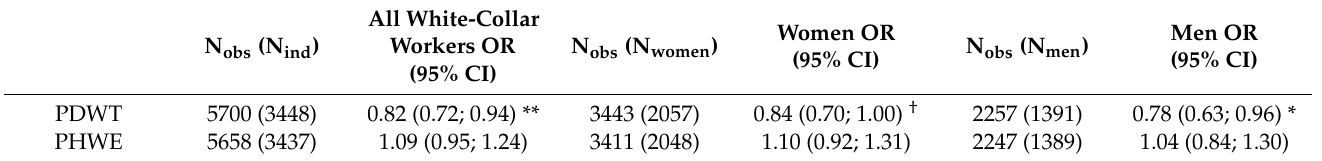
Table 2. White-collar workers. Odds ratio (OR) and 95% confidence interval (CI) of retired (1) vs. still in work (0) two years later in relation to PDWT and PHWE in dichotomised variables. Separate models.